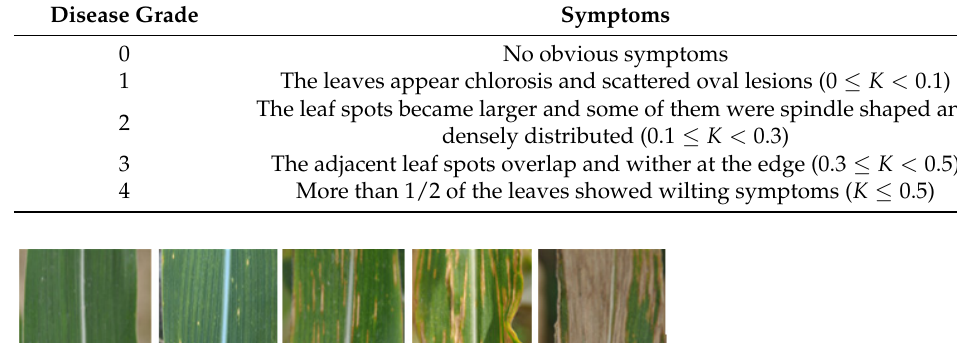
Figure 2. Level image sample. Table 1. Disease classification standard.